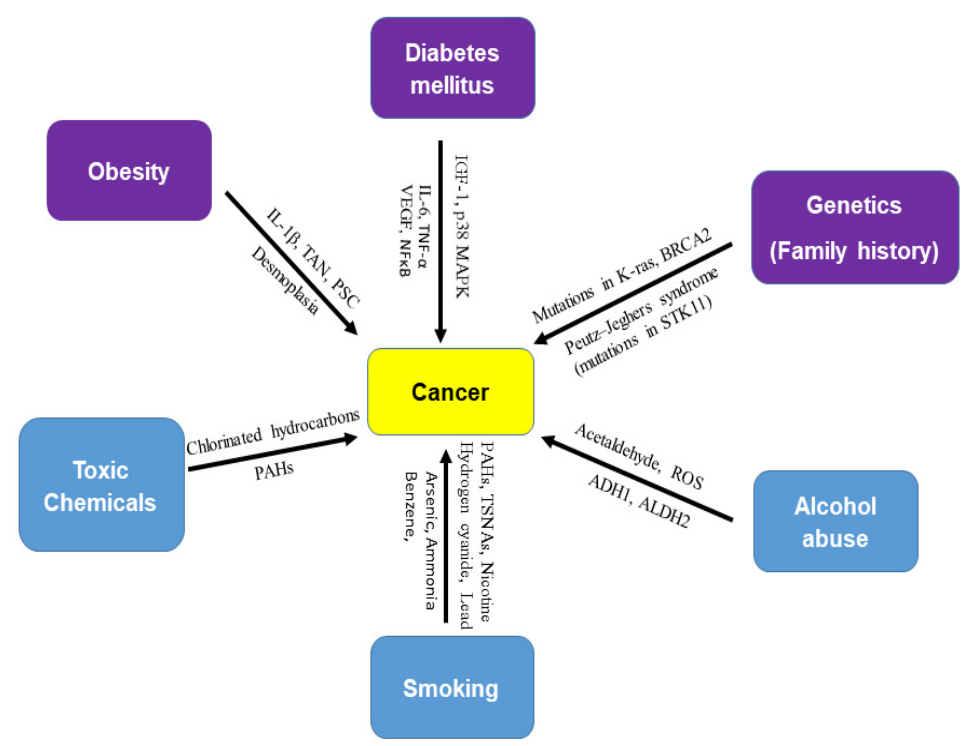
Figure 1. Risk factors of cancer. There are several risk factors for cancer. Obesity (IL-1 β , TAN, PSC, desmoplasia), diabetes mellitus (IGF-1, p38 MAPK, IL-6, TNF- β , VEGF, and NF- κ B), and genetics (mutations in K-ras, BRCA2, and STK11) are biological risk factors for cancer. Toxic chemicals (chlorinated hydrocarbons and polycyclic aromatic hydrocarbons), alcohol abuse (acetaldehyde, ROS, ADH1, and ALDH2), and smoking (nicotine, hydrogen cyanide, formaldehyde, lead, arsenic, ammonia, benzene, carbon monoxide, nitrosamines, and polycyclic aromatic hydrocarbons), are external or environmental risk factors of cancer. Smoking is known as a strong carcinogen in many cancers. Most cancer cases are attributed to environmental factors but a small percentage are involved in gene mutations and hereditary traces. Peutz–Jeghers syndrome (PJS) is caused by mutations in the tumor suppressor STK11 gene.